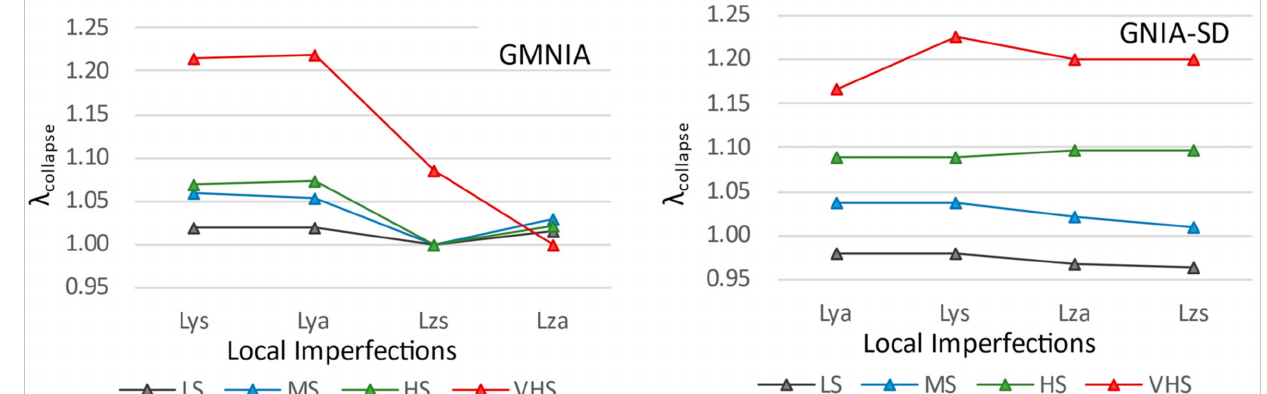
Figure 8. Variation of the ultimate load factor with the imperfection pattern for GMNIA and GNIA-SD